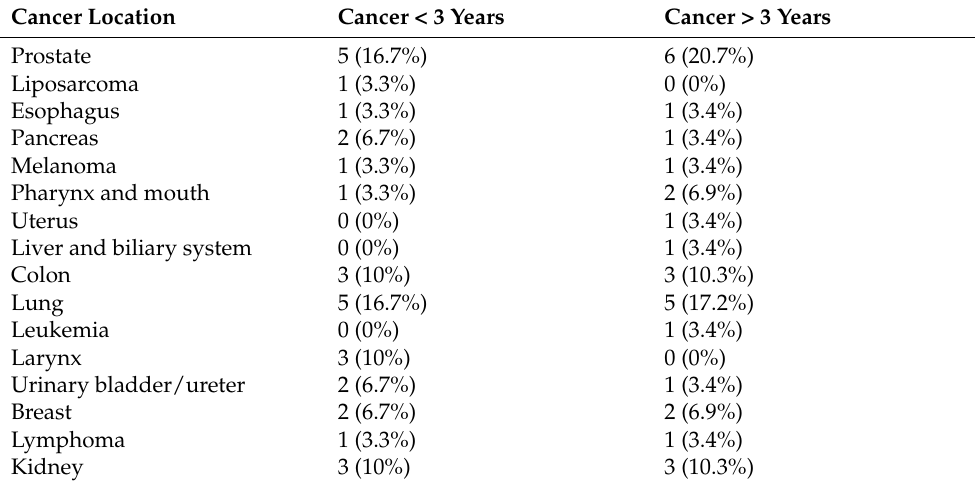
Table 2. Location of the cancers diagnosed during